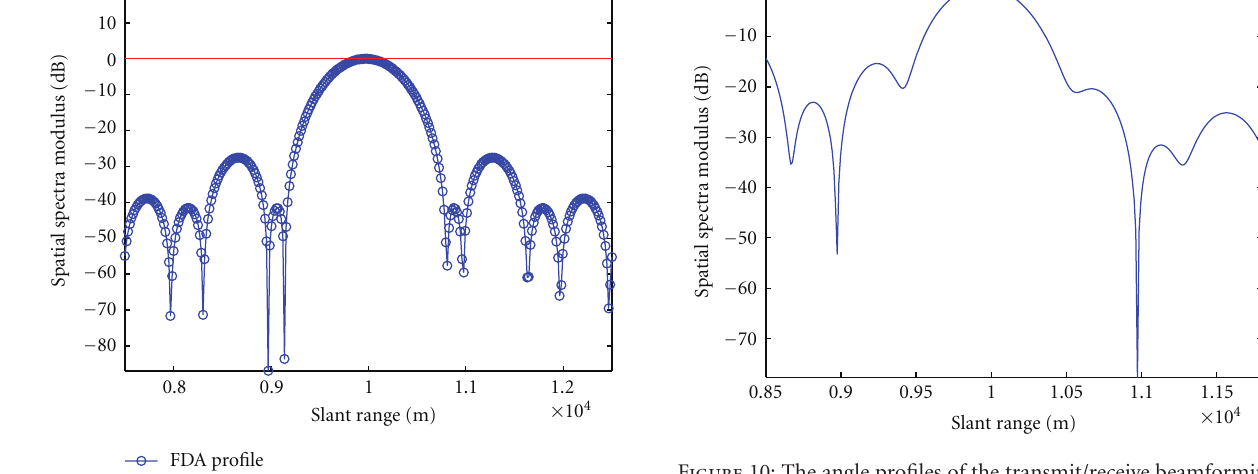
Figure 10: The angle profiles of the transmit/receive beamforming output at the target’s angle.